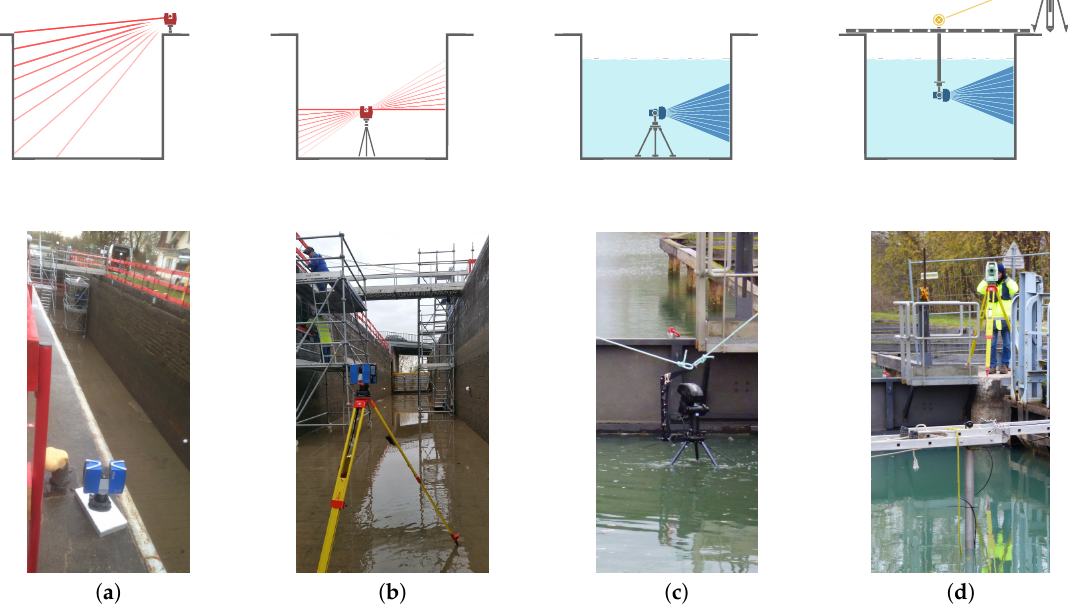
Figure 4. Schematic view (top line) and photograph (bottom line) of the configurations used for the survey: TLS from ( a ) the top and ( b ) the bottom of the lock chamber; MSS operated ( c ) using an immersed tripod or ( d ) upside down from the water surface. TLS acquisition items appear in red, MSS items in blue, and tacheometric ones in